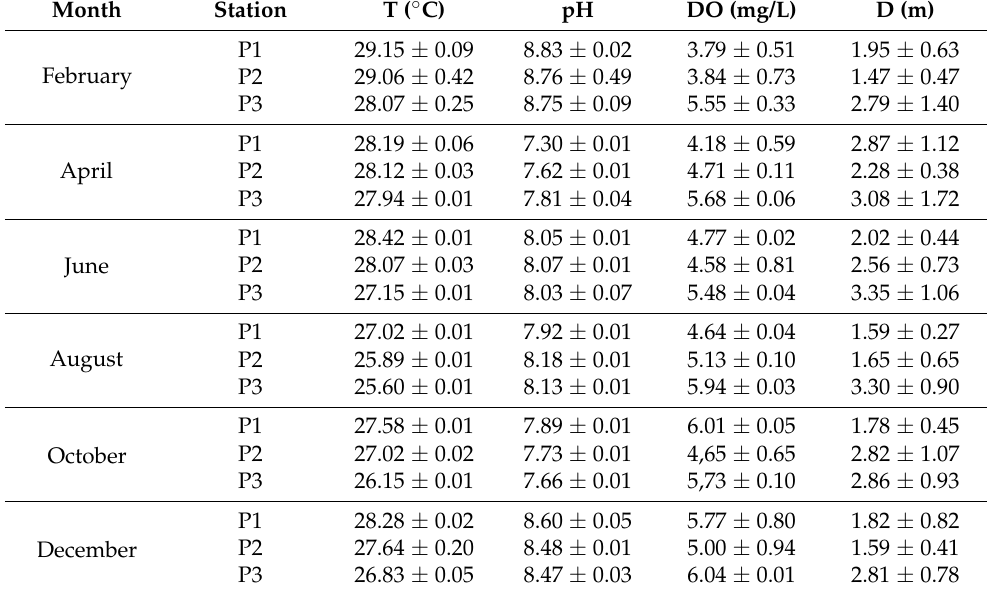
Table 1. Intra-annual and spatial environmental variables in the Piranji Estuary (equatorial South- western Atlantic, Brazil, 2015). (T) temperature, pH, (DO) dissolved oxygen and (D) depth. Point upstream of the river (P1) to the point closest to the estuarine mouth